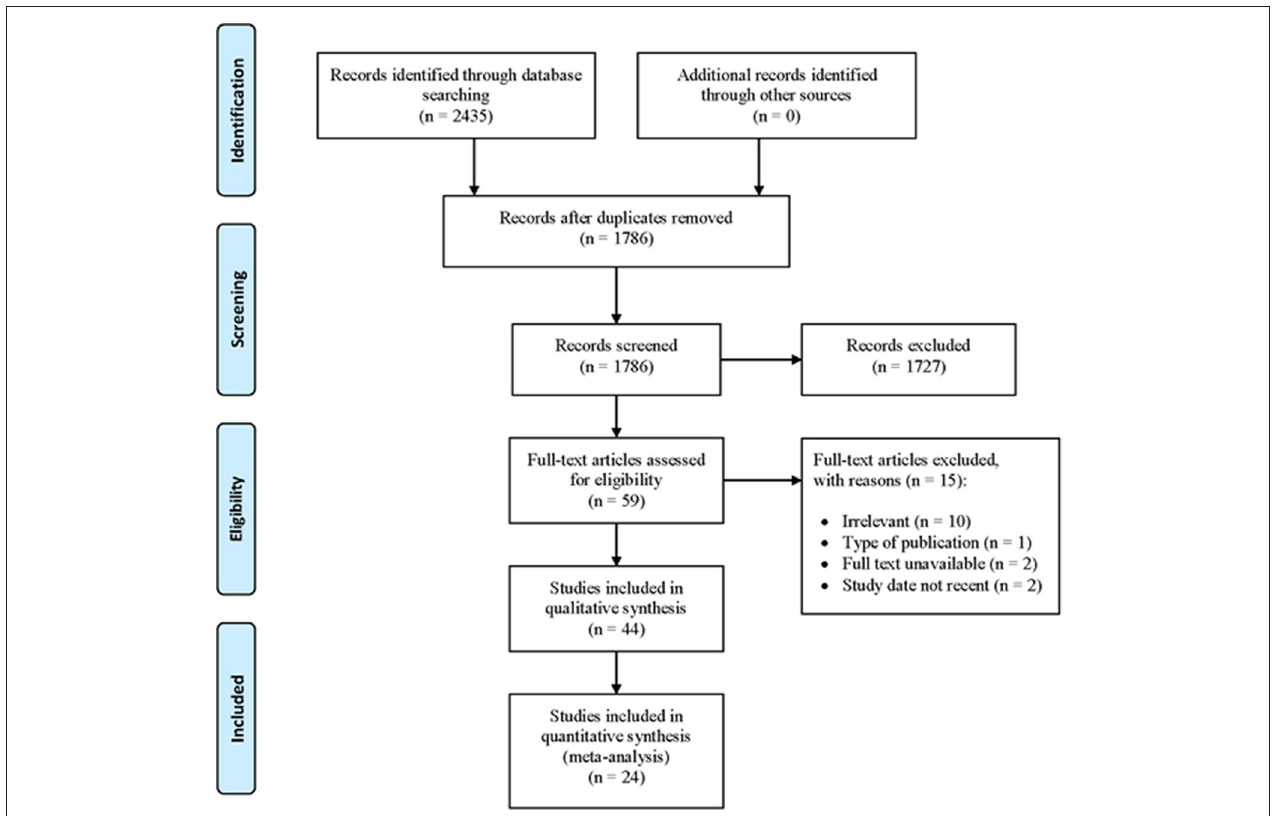
FIGURE 1 | PRISMA flow